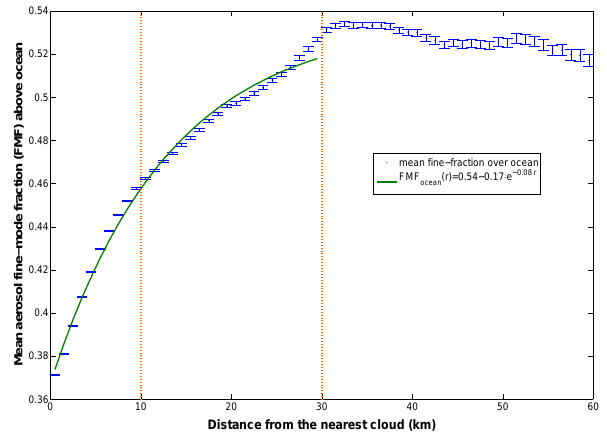
Fig. 6. Global mean aerosol fine-mode fraction (FMF) as a function of the distance from the nearest cloud, retrieved above ocean (blue dots), and its exponential fitting function (green line), for distances of 0–30km from the nearest cloud. The error bars represent the standard mean error. All data are based on MODIS Terra observa- tion for 28 July 2008. Similarly to Fig. 5, the constant distance lines highlight the values for R 0 = 10km and for the calculated global characteristic